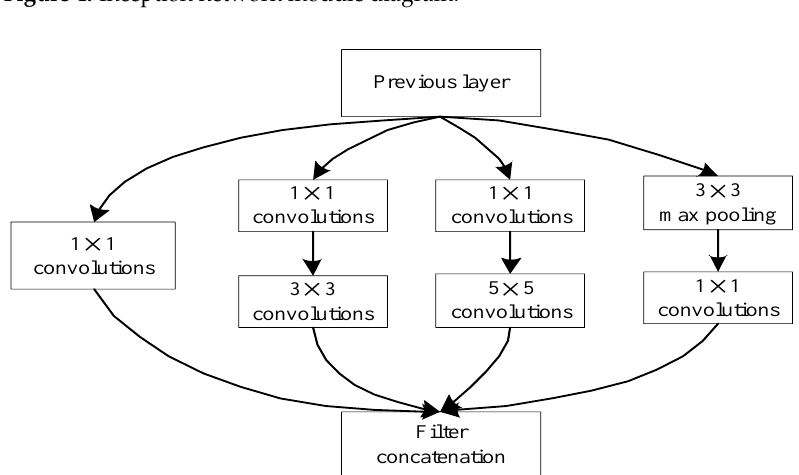
Figure 4. Inception network module diagram.